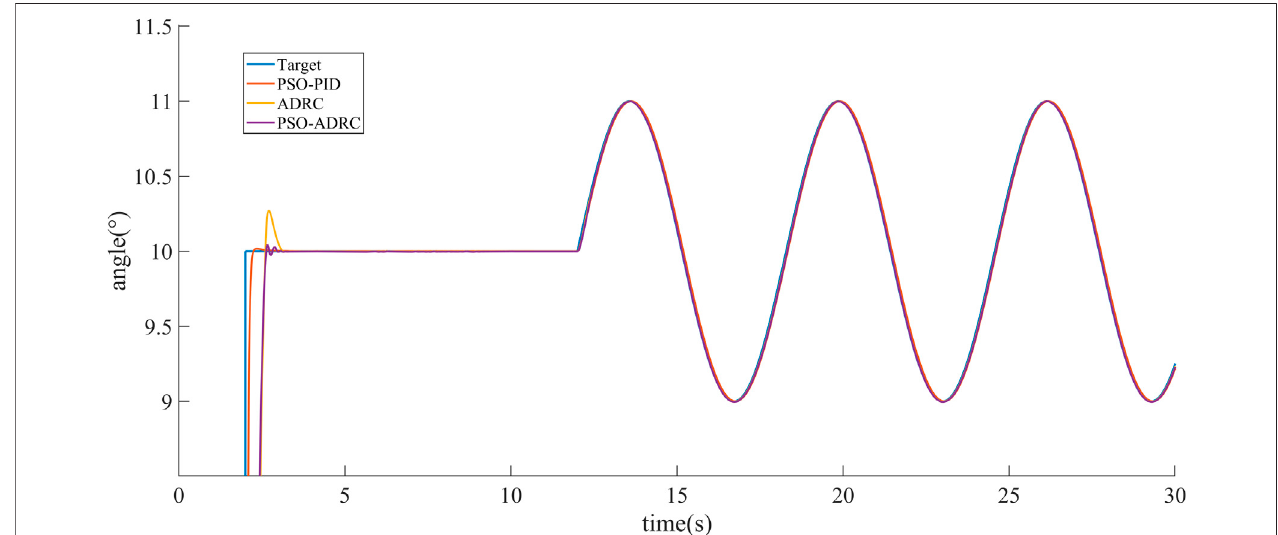
FIGURE 6 | Signal tracking under no interference.